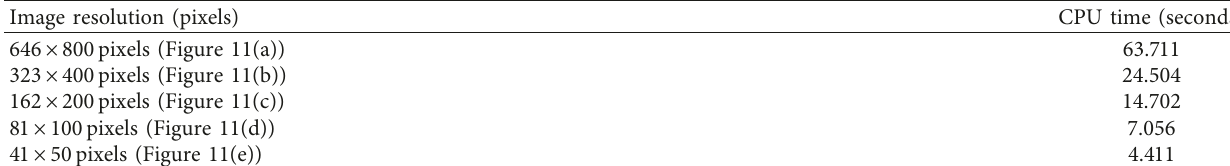
Table 2: The CPU time corresponding to each segmentation result in Figure 11.